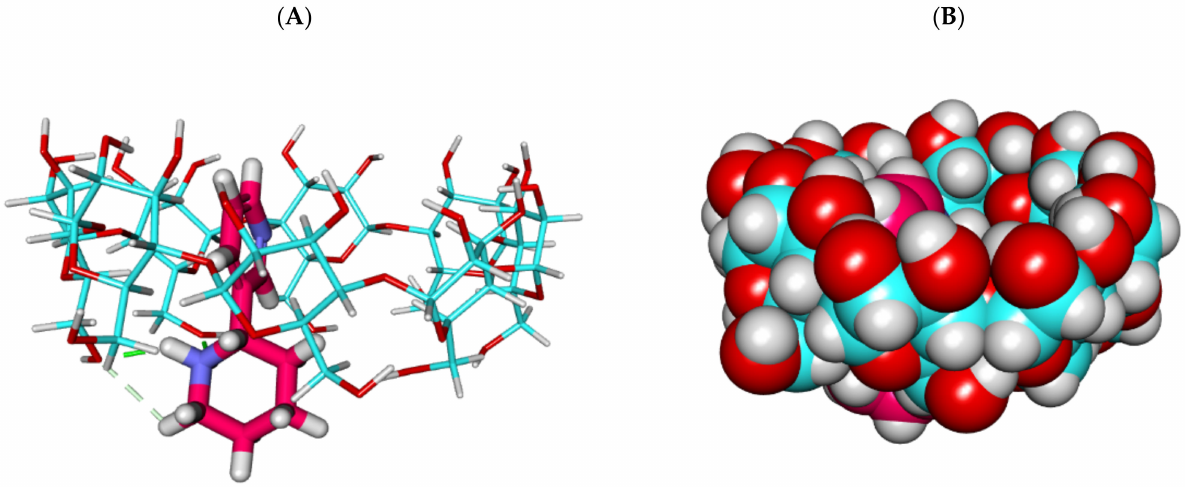
Figure 5. The best-ranked docking poses of anabasine with γ CD, front view, as sticks ( A ), and CPK ( B ).